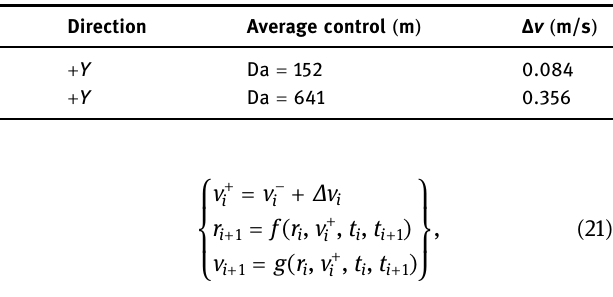
Satellite Leader Follower